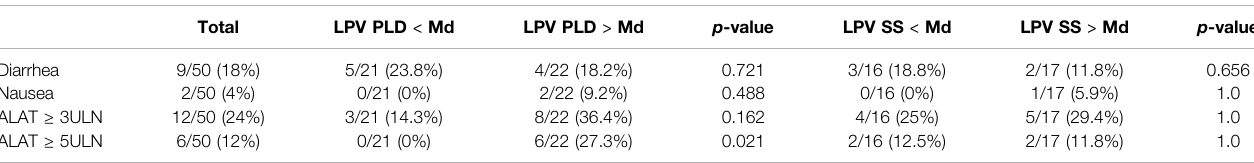
TABLE 3 | Side effects of patients receiving high dose LPV/RTV.